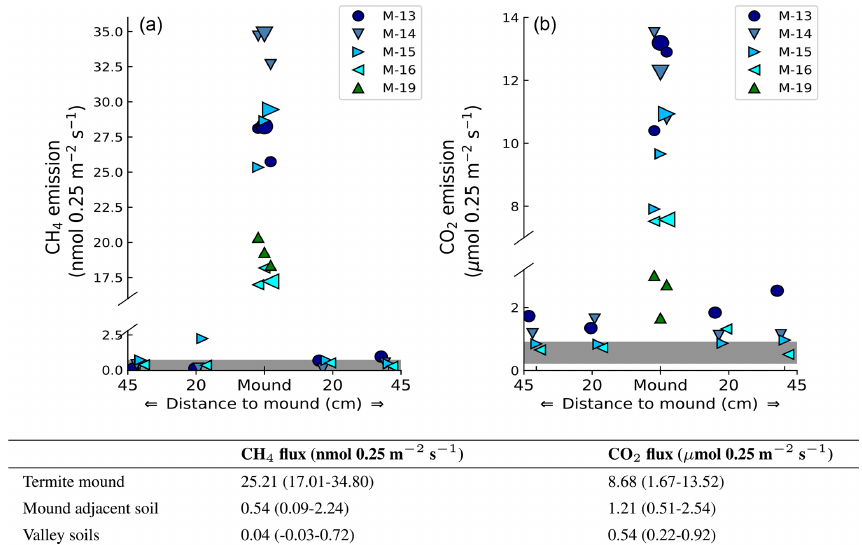
Figure 2. Measured mound emissions and mound-adjacent soil fluxes for CH 4 (a) and CO 2 (b) for mound nos. 13, 14, 15, and 16 expressed in nmol 0.25m − 2 s − 1 for CH 4 and µmol 0.25m − 2 s − 1 for CO 2 (collar area is 0.25m 2 ). Note that for CO 2 the total mound emissions per collar area not corrected for soil respiration are shown and stated. The centrally placed markers are the measured mound emissions (also for mound no. 19); the larger marker indicates the day-specific mound emission when mound-adjacent soil fluxes were measured. The grey bar indicates the range of additionally measured soil valley fluxes. The range and average flux for each group of measurements are given in the table. On average, measured mound CH 4 and CO 2 fluxes were a factor of 630 and 16 higher in comparison to the surrounding soil valley fluxes.